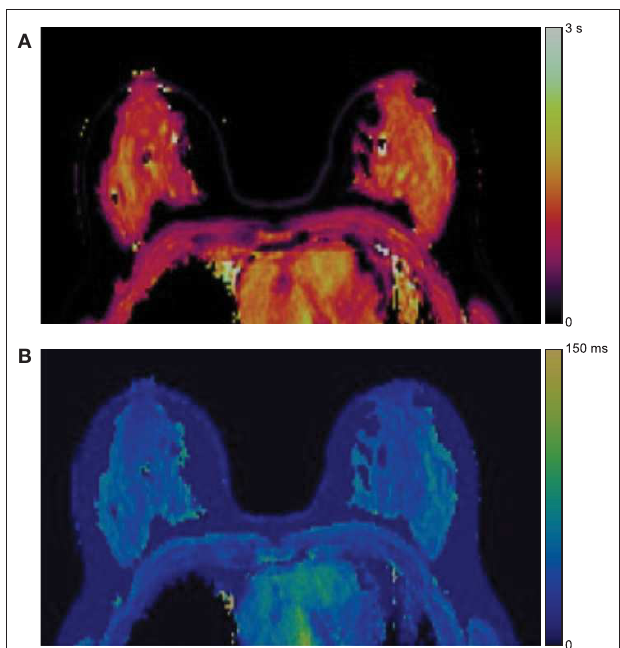
FIGURE 7 | Example MR fingerprinting of the breast. Representative (A) T 1 and (B) T 2 MR fingerprinting color maps from one subject. Reprinted with permission from Chen et al. ( 109); © 2019 International Society for Magnetic Resonance in